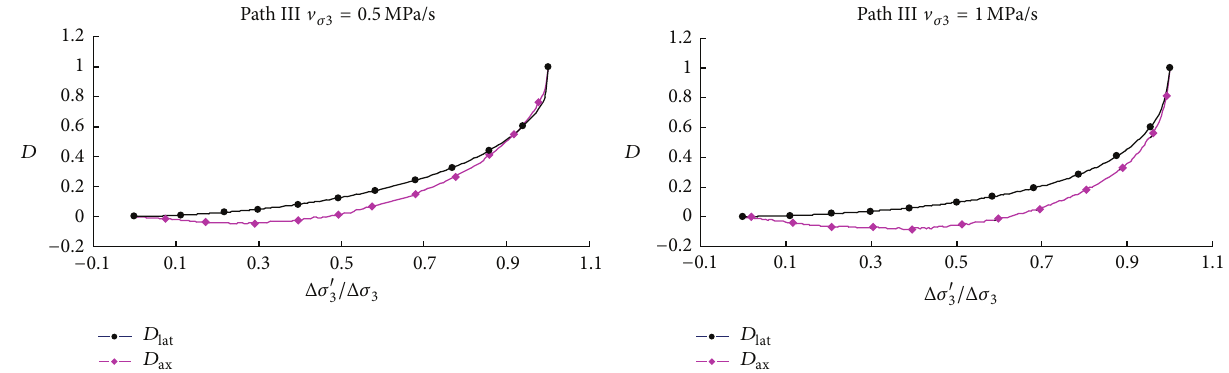
Figure 2: The evolution of variation of axial strain increment with unloading confining